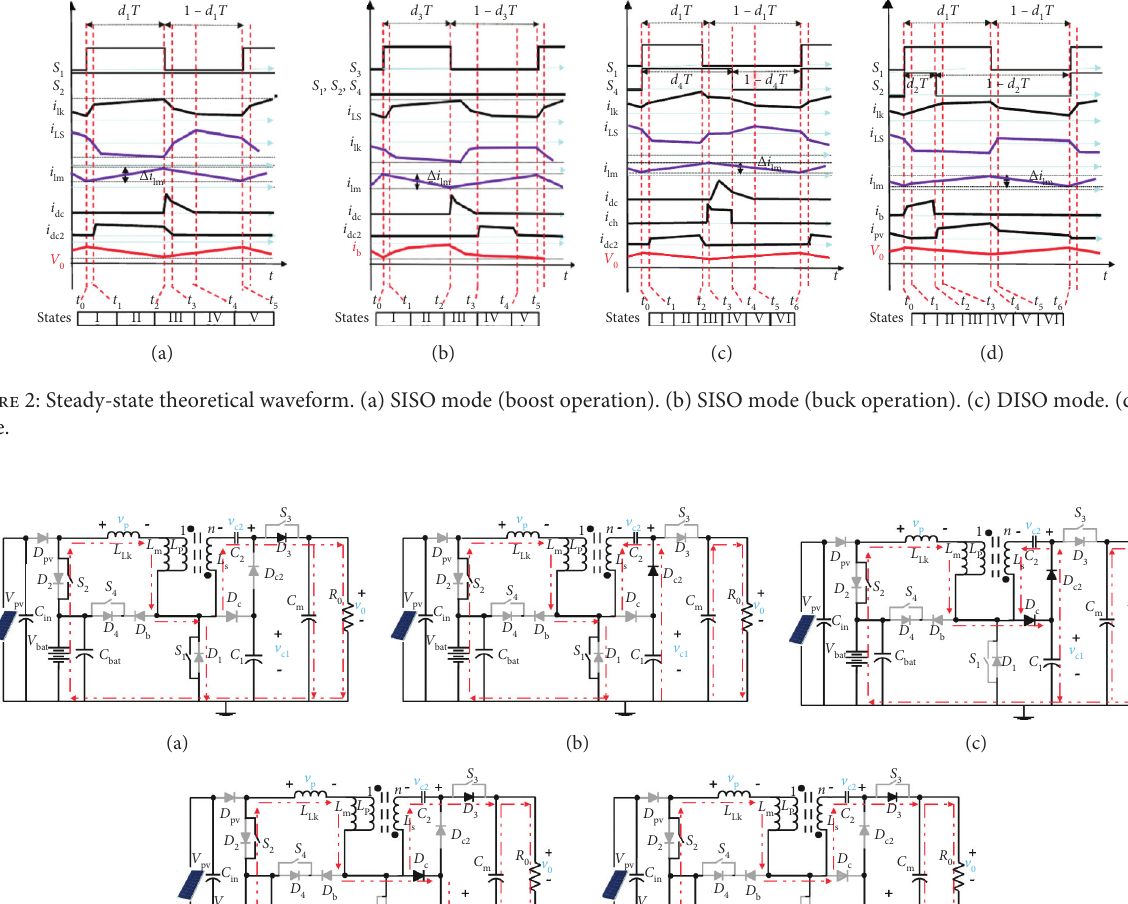
∼ t . (b) t ∼ t . 0 1 1 2